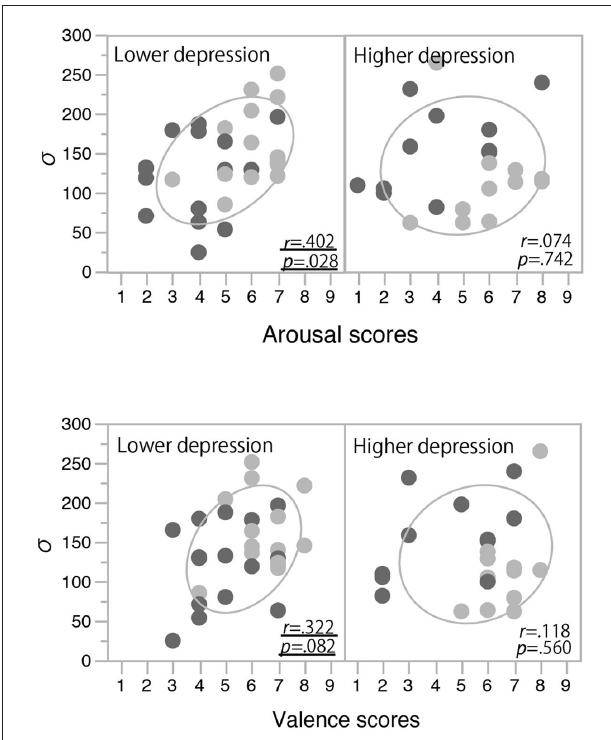
FIGURE 4 | Correlations between mood rating scores and σ values in Experiment 1. Light and dark gray plots indicate happy and non-happy conditions, respectively. Ellipses show a probability ellipse of